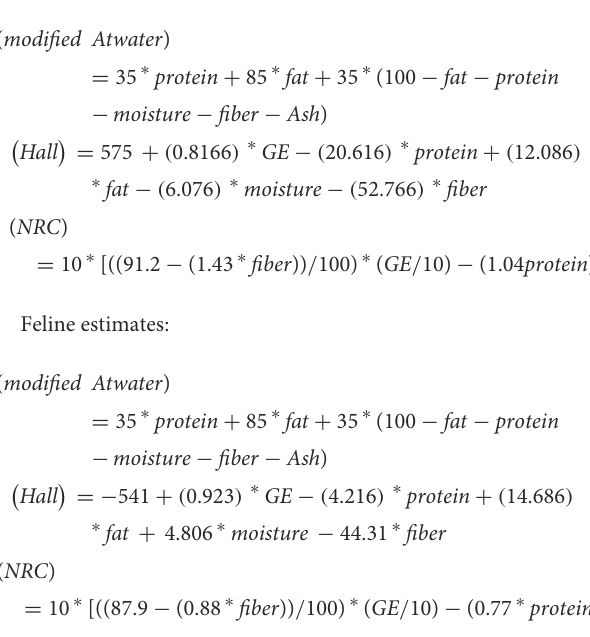
The statistical analysis performed used SAS 9.4 (SAS Institute, Cary, NC, USA). The absolute value of the difference between predicted and measured metabolizable energy (ME) was calculated. These differences were then compared among prediction equations by using PROC MIXED in SAS within the dry and wet food categories of each species, using individual pet identification as a random variable. When the differences were not normally distributed, log values of the differences were used for mean separation. A p